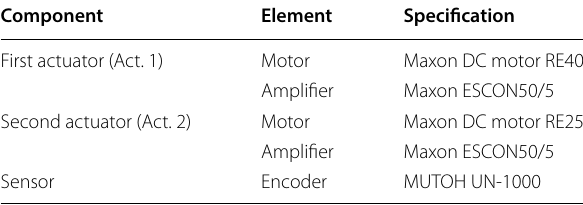
Table 1 Specifications of experimental plant Component Element